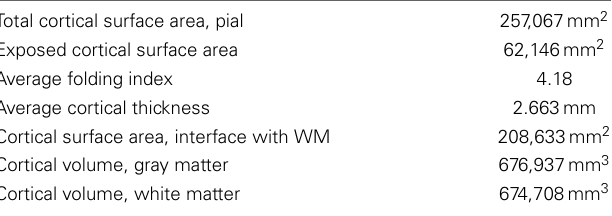
Table 1 | Cellular composition of the African elephant brain. Structure